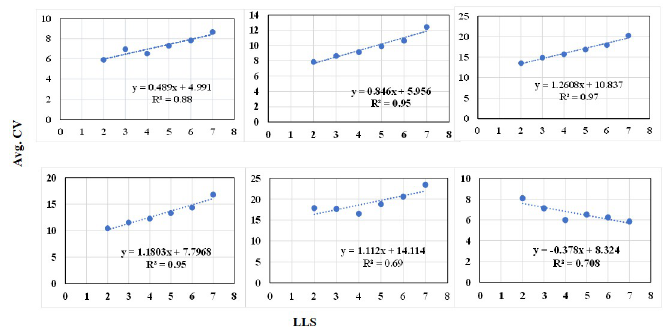
Fig 11. The linear association between LLS rating and Average CV derived for vegetation index a) NDRE, b) SAVI c) DVI d) LAI e) SR and f) REVI. Note the CV is averaged based on the LLS manual rating measured on DAP-112.